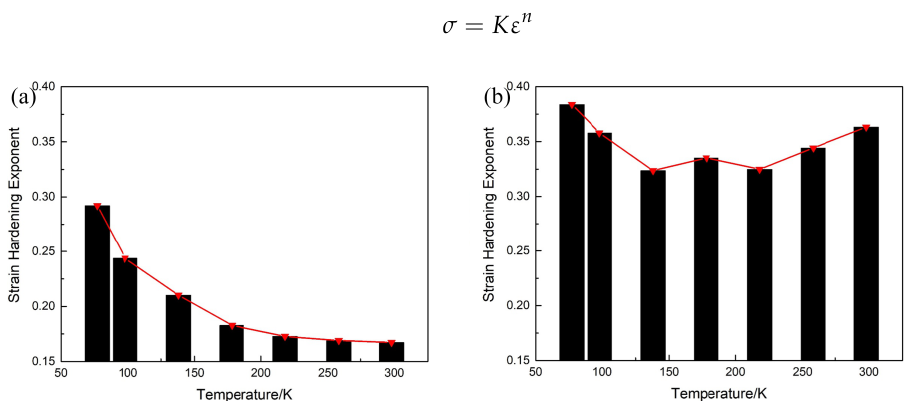
Figure 5. Strain hardening exponent of 2195 alloy at 298 K to 77 K: ( a ) O-state, ( b )